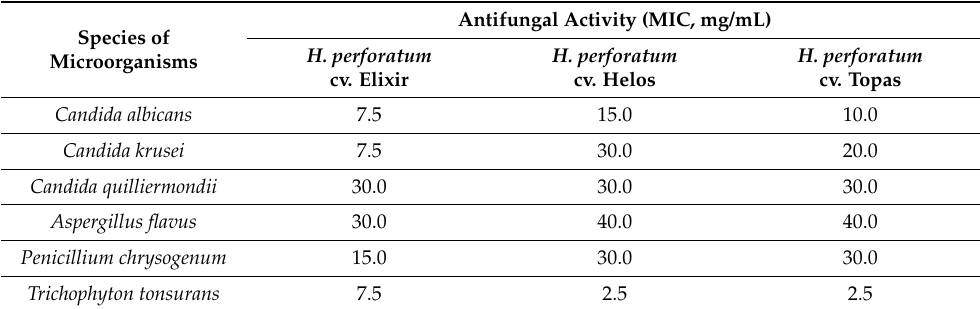
Table 4. Antifungal activity (MIC—minimum inhibitory concentration) of the methanolic extracts obtained from the biomass of in vitro agitated cultures of the H. perforatum cultivars Helos, Elixir, and Topas (MS, 0.1 mg/L BAP and 0.1 mg/L NAA, 5